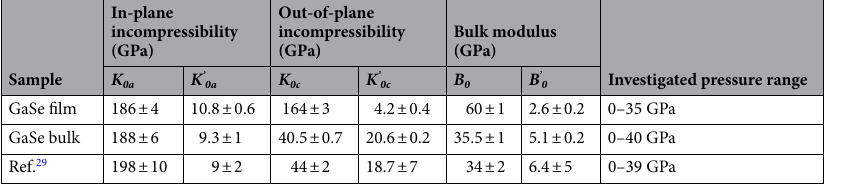
Table 1. Incompressibility parameter and bulk modulus of the SDD-GaSe film and GaSe bulk extracted from the inverted Birch-Murnaghan EoS.